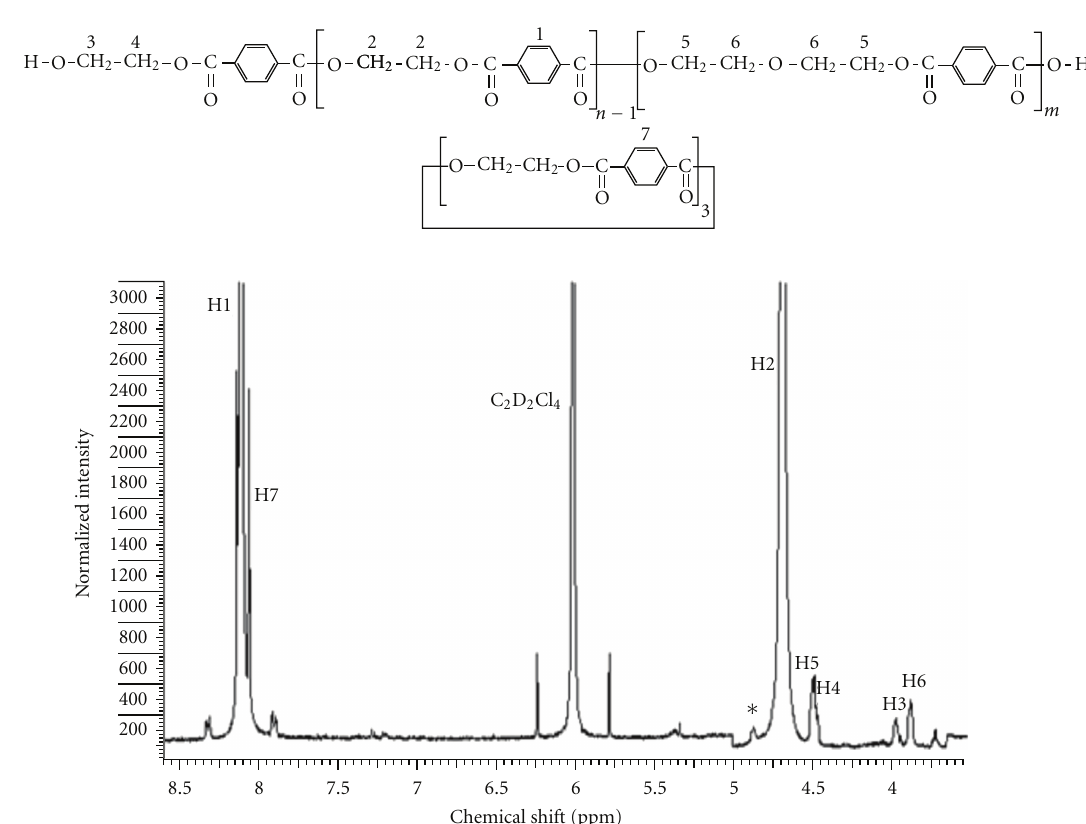
Figure 12: 1 H-NMR spectrum of PET (400 MHz, (CDCl 2 ) 2 , reference (CDCl 2 ) 2 , d (CHCl 2 ) 2 6 ppm). ∗ 13 C satellite peak.